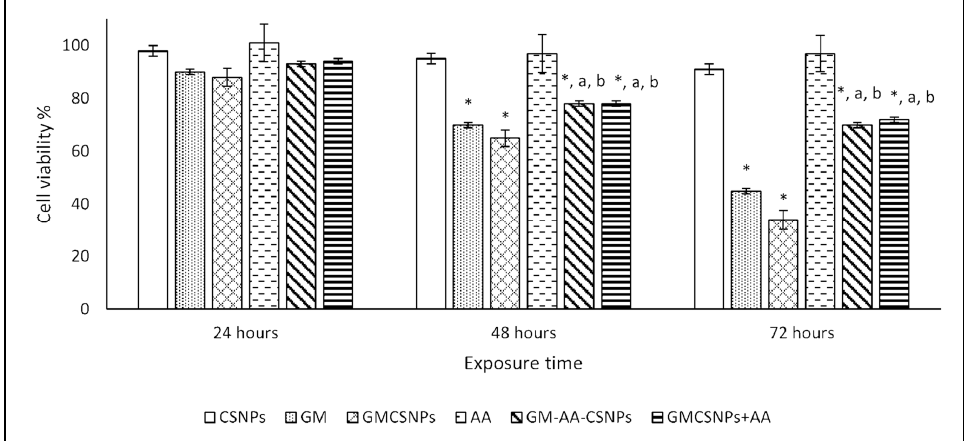
Figure 6. Cell viability % of HSF cells after exposure to CSNPs, GM, AA, GM–AA–CSNPs, and GMCSNPs/AA mixture at different times. (*, a, b) represents the significant difference at p < 0.05 from the control, GM, and GMCSNPs groups,